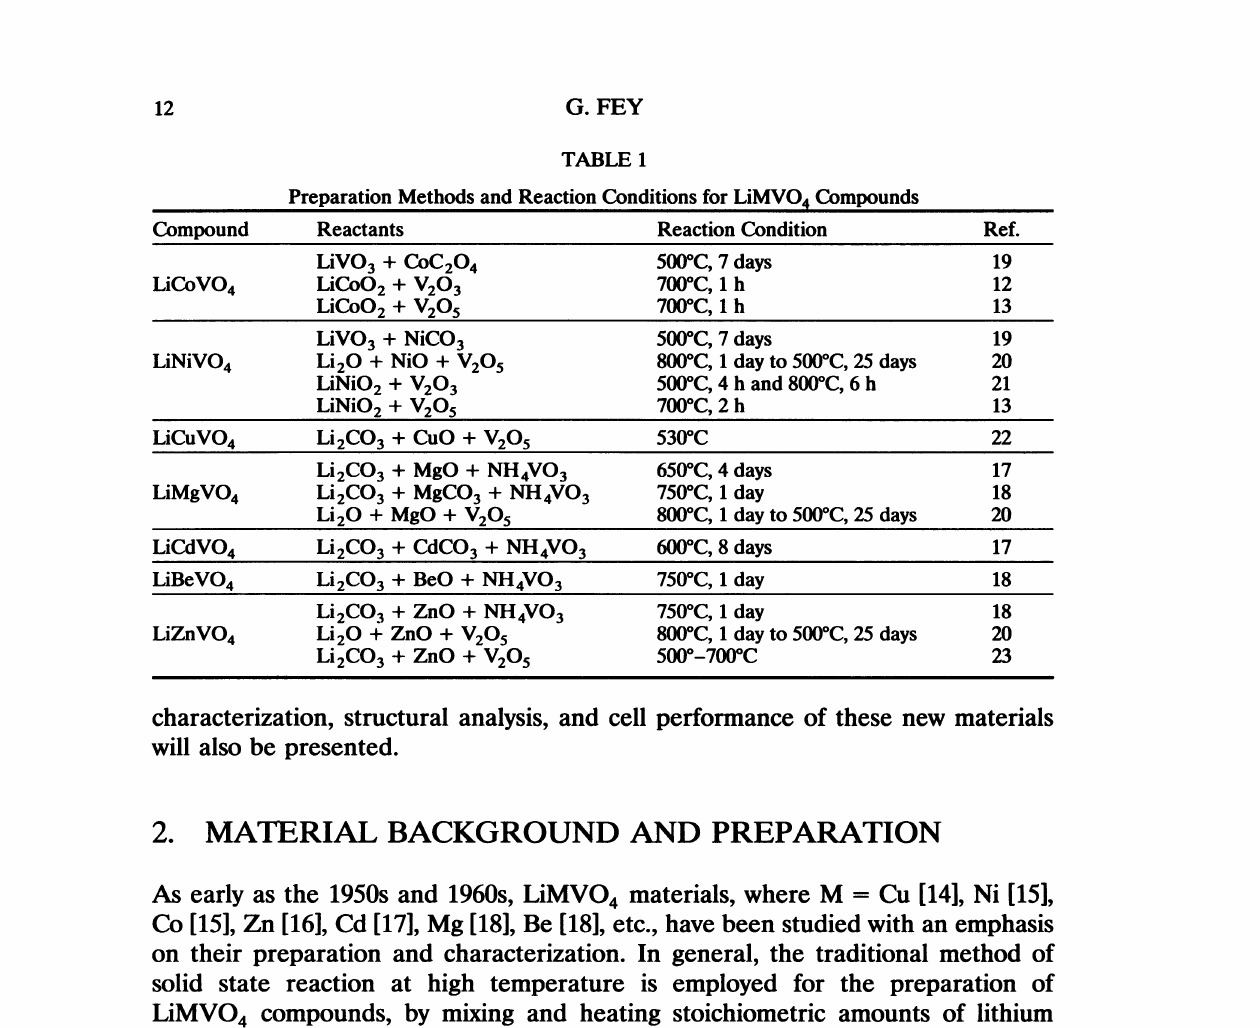
Types of Structures of LiMVO Structure